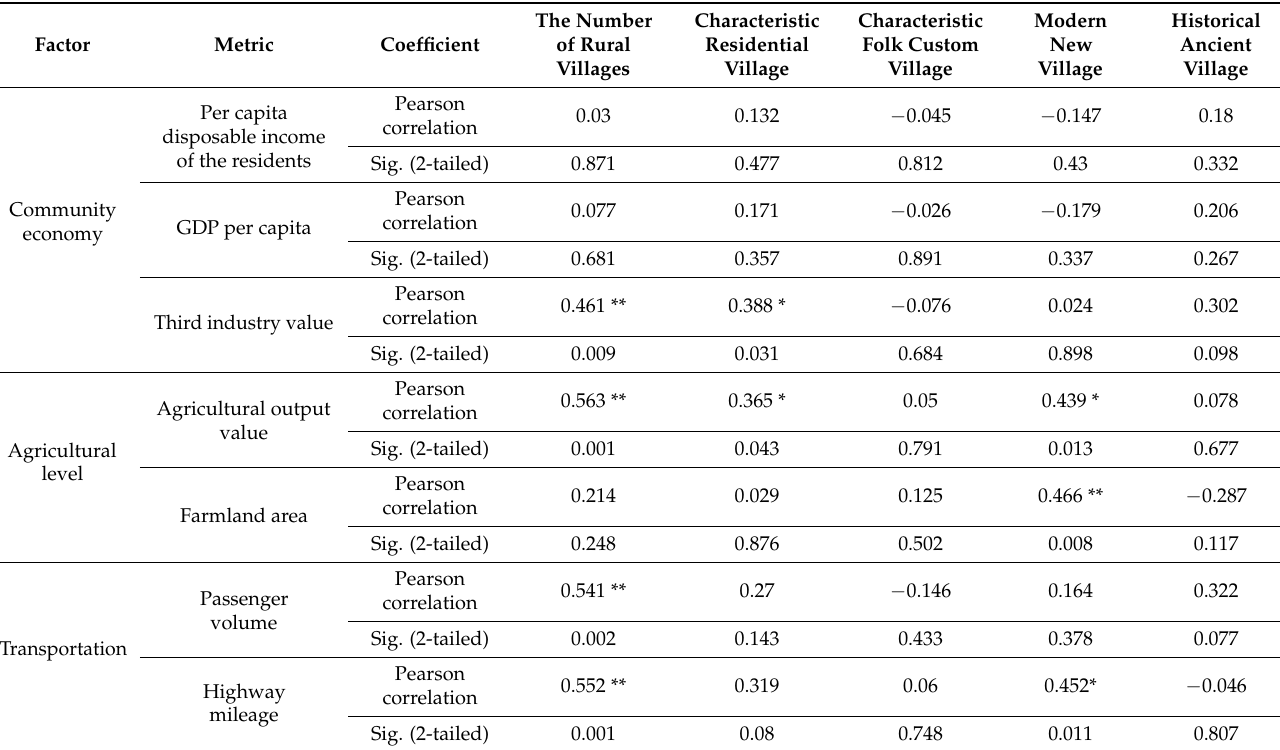
Table 4. Correlation analysis of the factors influencing the spatial distribution of beautiful leisure villages in